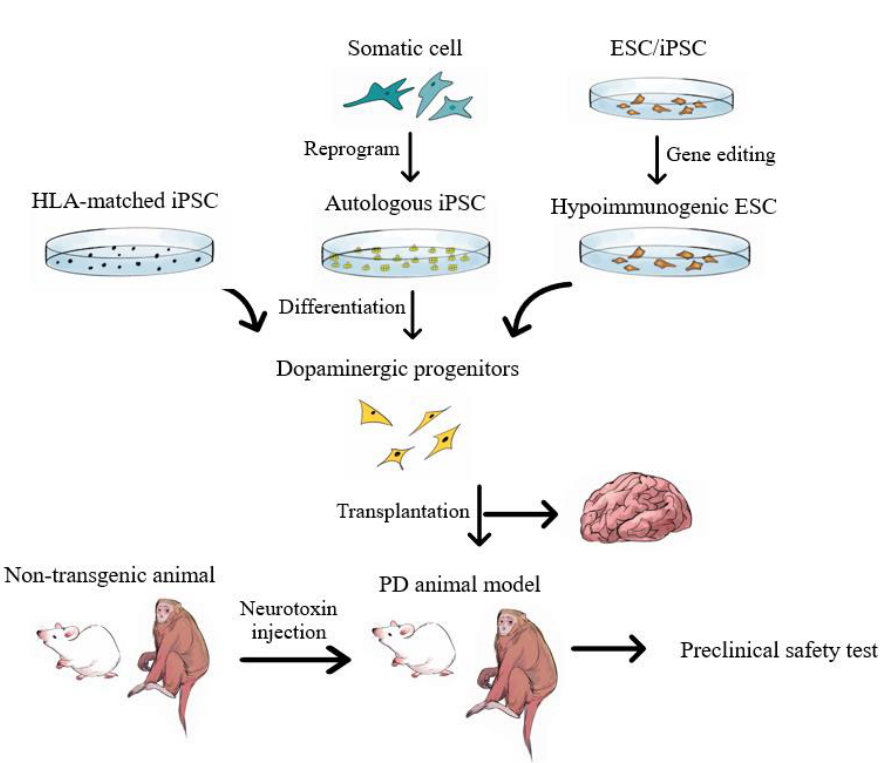
Figure 2. Stem cell therapy for Parkinson disease. Dopaminergic progenitors could be obtained from di ff erent sources of pluripotent stem cells, which are either derived from somatic cells by epigenetic reprogramming, or from IVF-derived human embryos. HLA-matched iPSC or gene-edited hyopimmunogenic ESC / iPSC lowers the risk of graft-induced rejection. Preclinical tests in neurotoxin-induced PD models in rodents and nonhuman primates show promising therapeutic e ff ect. IVF: in vitro fertilization; HLA: human leukocyte antigen.